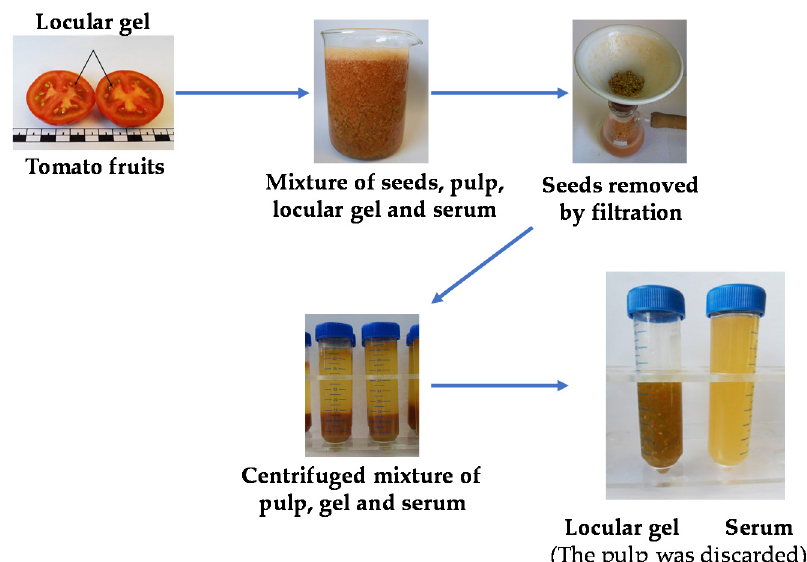
Figure 6. Scheme of locular gel and serum production from tomato fruits. Gs samples of Camone were extracted in triplicate by optimised solid-liquid ultrasound assisted protocols as previously reported [15]. The extracts were tested for total antioxidant capacity on the basis of quenching ability against the radical DPPH · and radical cation ABTS + , detected photometrically. Antioxidant capacity was expressed as Trolox Equivalent (TEAC) and the final results were expressed as µ mol Trolox Equivalent (TE) / kg fresh weight (fw) for both TEAC / ABTS and TEAC / DPPH measurements. The methods were those reported in [42,43], with some modifications [15].